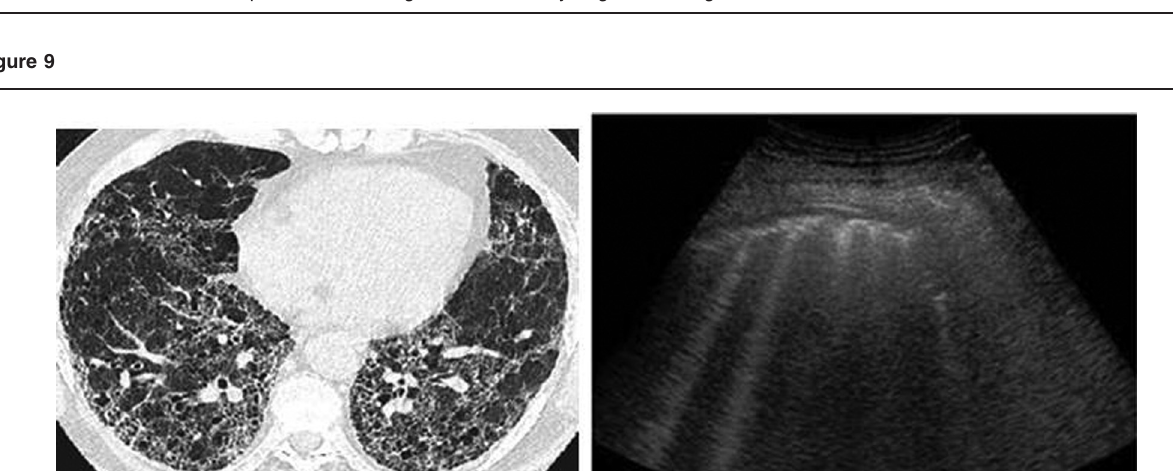
Illustrates the thickness of the pleural line among different severity degrees among cases.